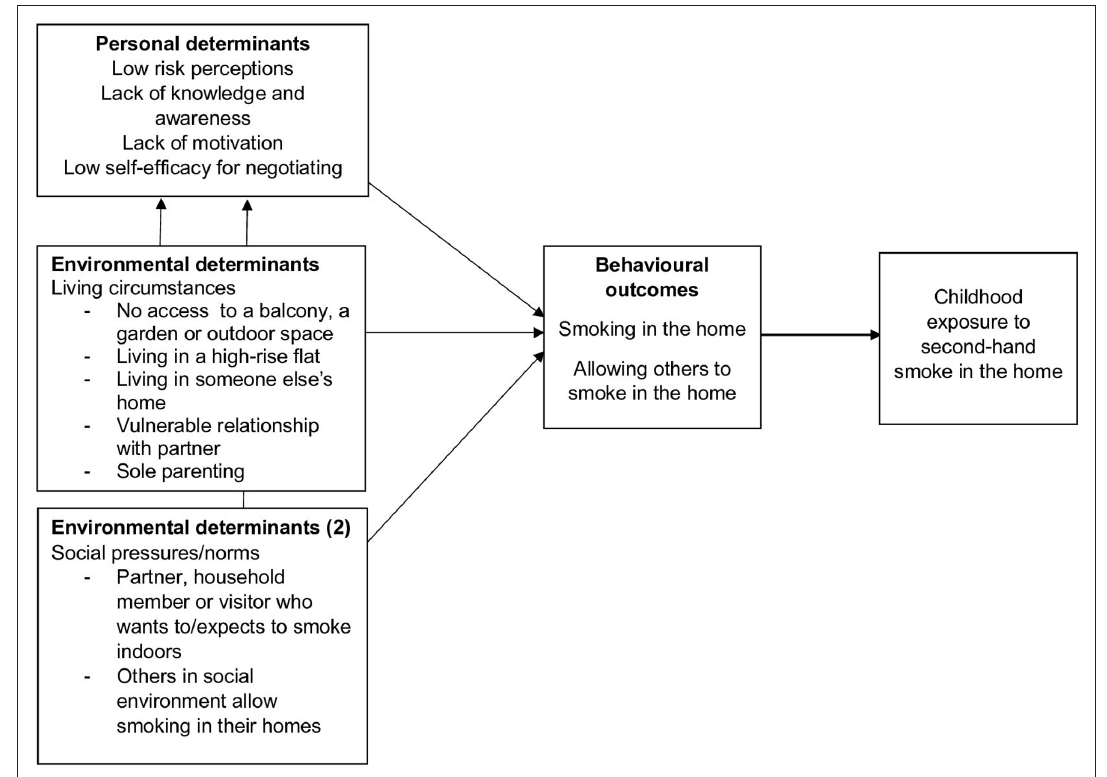
Figure 2: Logic model of the